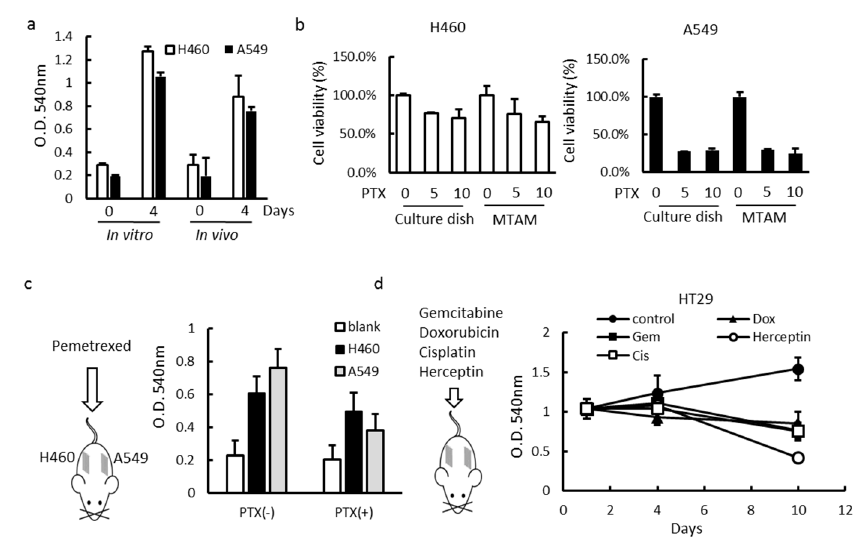
Figure 2. Anticancer drug screening of the MTAM-based HFA system ( a ) in vitro and in vivo cell culture of H460 and A549 which demonstrated superior cell proliferation within 4 days when cultured using MTAM as a substrate, the growth inhibition of H460 and A549 cells by pemetrexed ( b ) in vitro or ( c ) in vivo. ( d ) Growth inhibition of HT29 cells in the MTAM implanted s.c. in mice. Drugs were administrated once daily by i.p. injection from days 3–7 after implantation (Student’s t-test; P < 0.05).